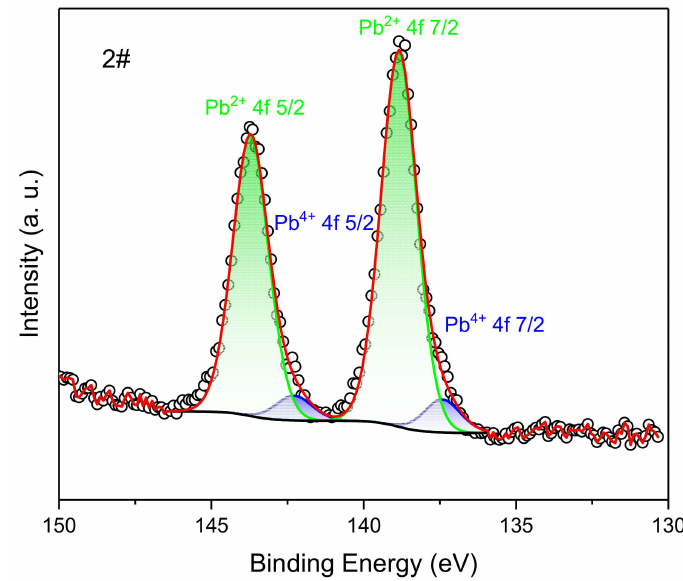
Figure 16. High-resolution XPS spectra in the Pb 4f region of the inner wall surface of the engine after the ignition experiment. The black line is the baseline, the black circle line is the peak of the original data, and the red line is the summation peak of the two valence states after the partial peak fitting. The blue and green areas are the proportions of the different valence states of Pb